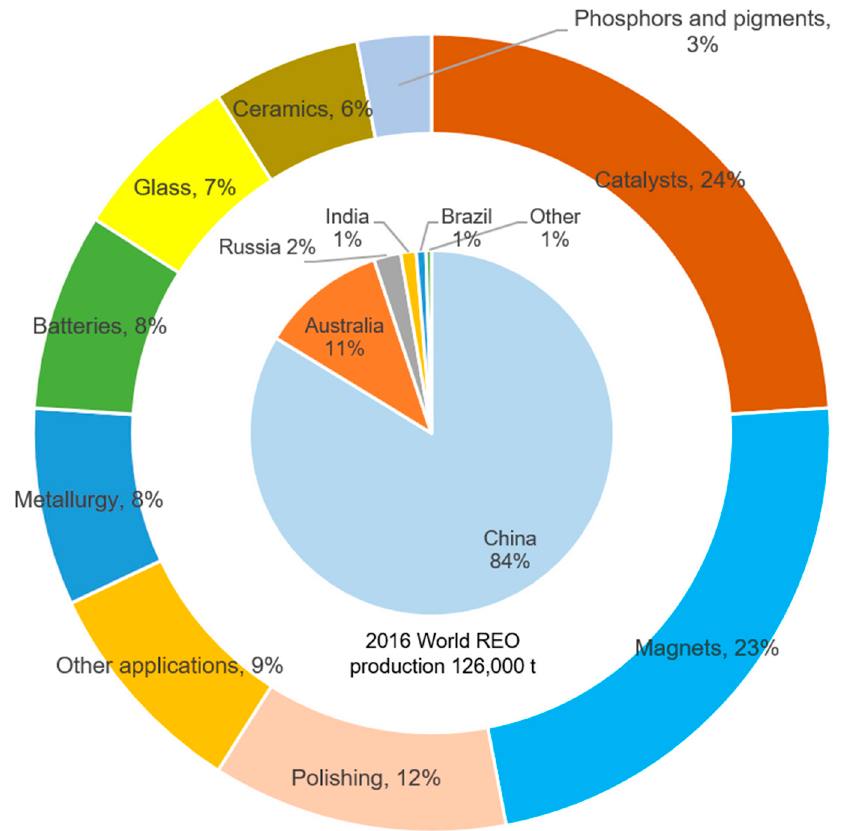
Figure 2. The distribution of global rare earth production and consumption in 2015, the consumption data obtained from [16], the production data adapted from [22].